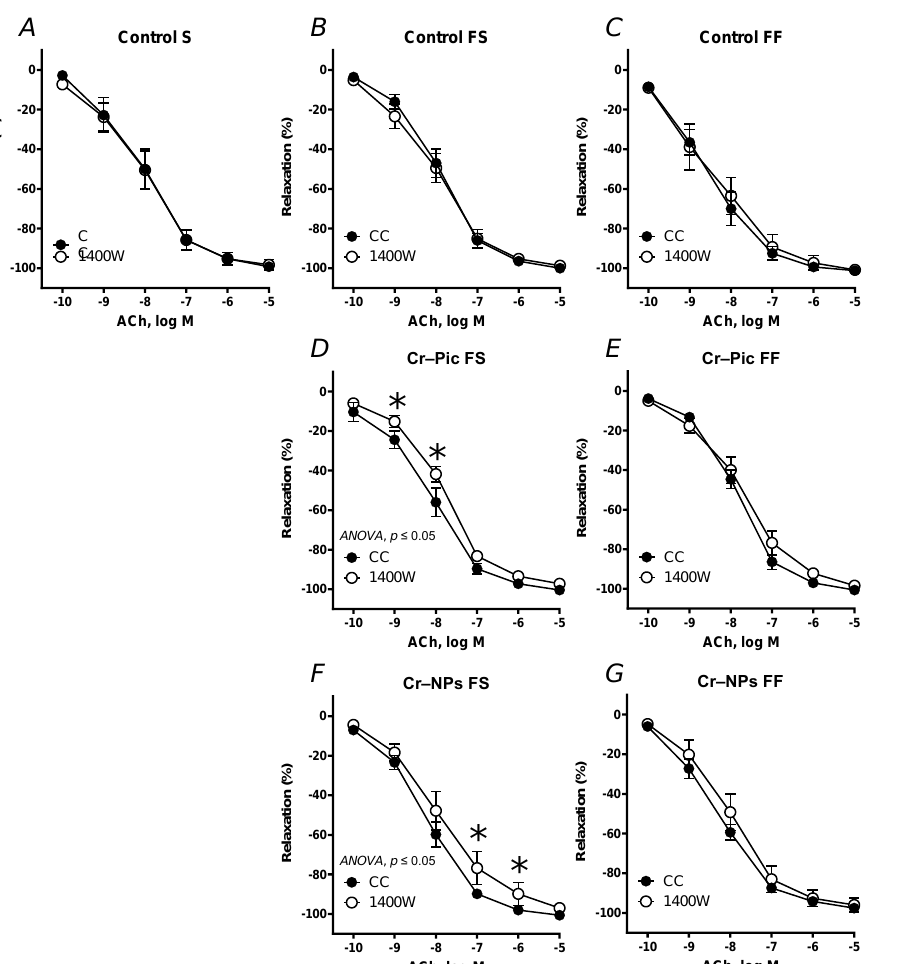
Figure 5. Effects of 1400W (1 µM) on the concentration – response curves to acetylcholine (ACh) in aortic rings from the following groups of rats: control S ( A ), control FS ( B ), control FF ( C ), Cr – Pic FS